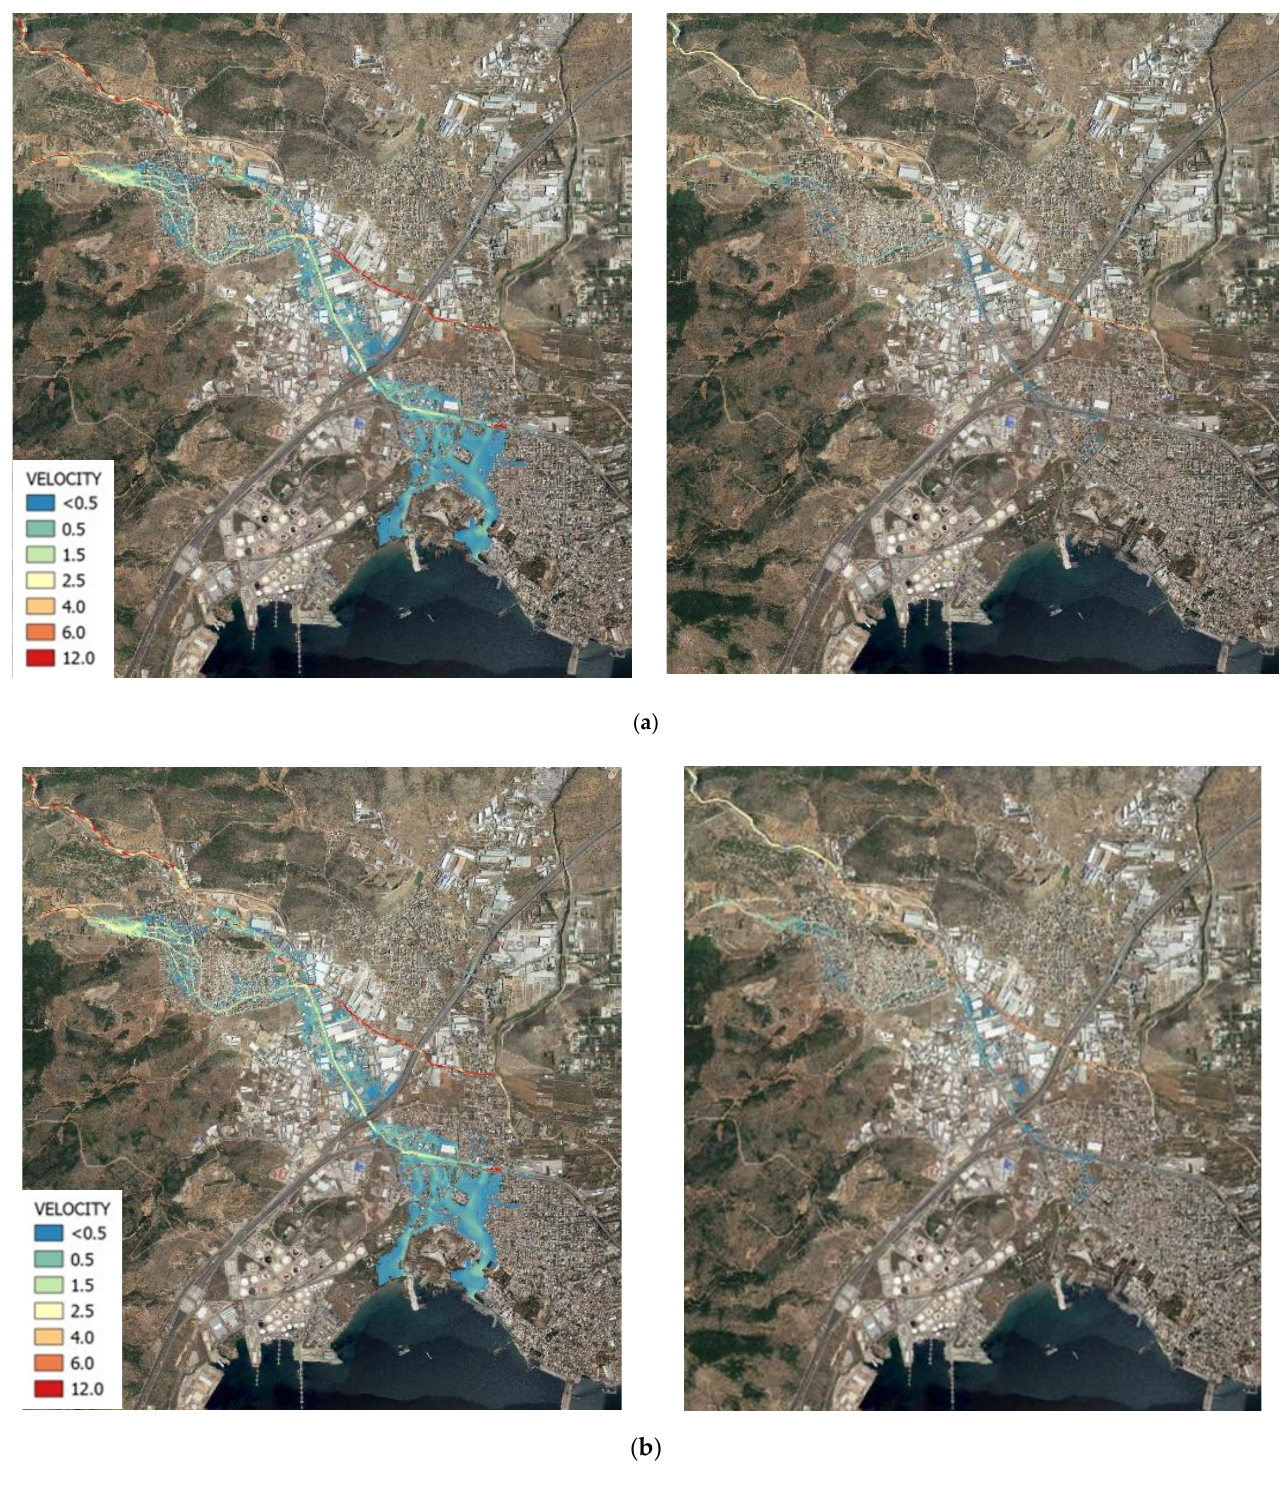
Figure 6. Maximum water velocities (m/s) for 4 indicative scenarios: ( a ) Scenarios S20-06 ( left ) and W20-06 ( right ) for T = 20 y and t = 6 h. ( b ) Scenarios S200-18 ( left ) and W200-18 ( right ) for T = 200 y and t = 18 h.